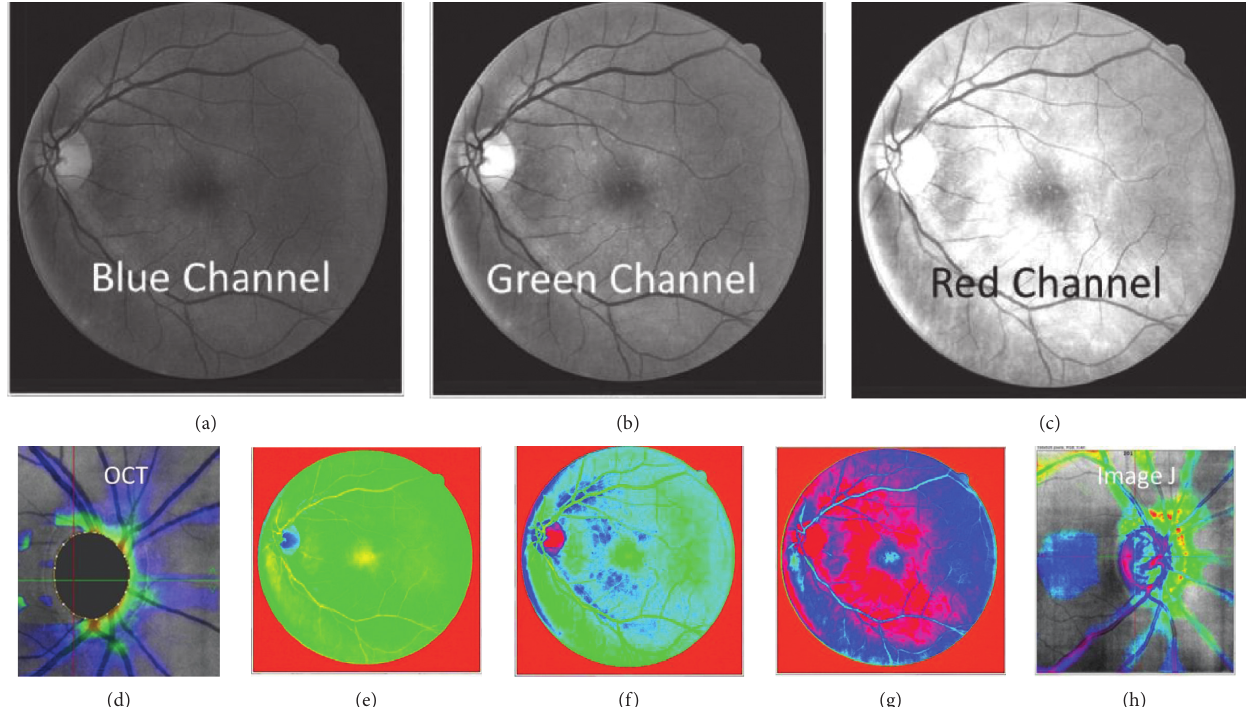
Figure 5: Splitting of the RGB channels in fundus images/optic nerve and resemblance of the blue channel ImageJ to the OCTthickness map of the